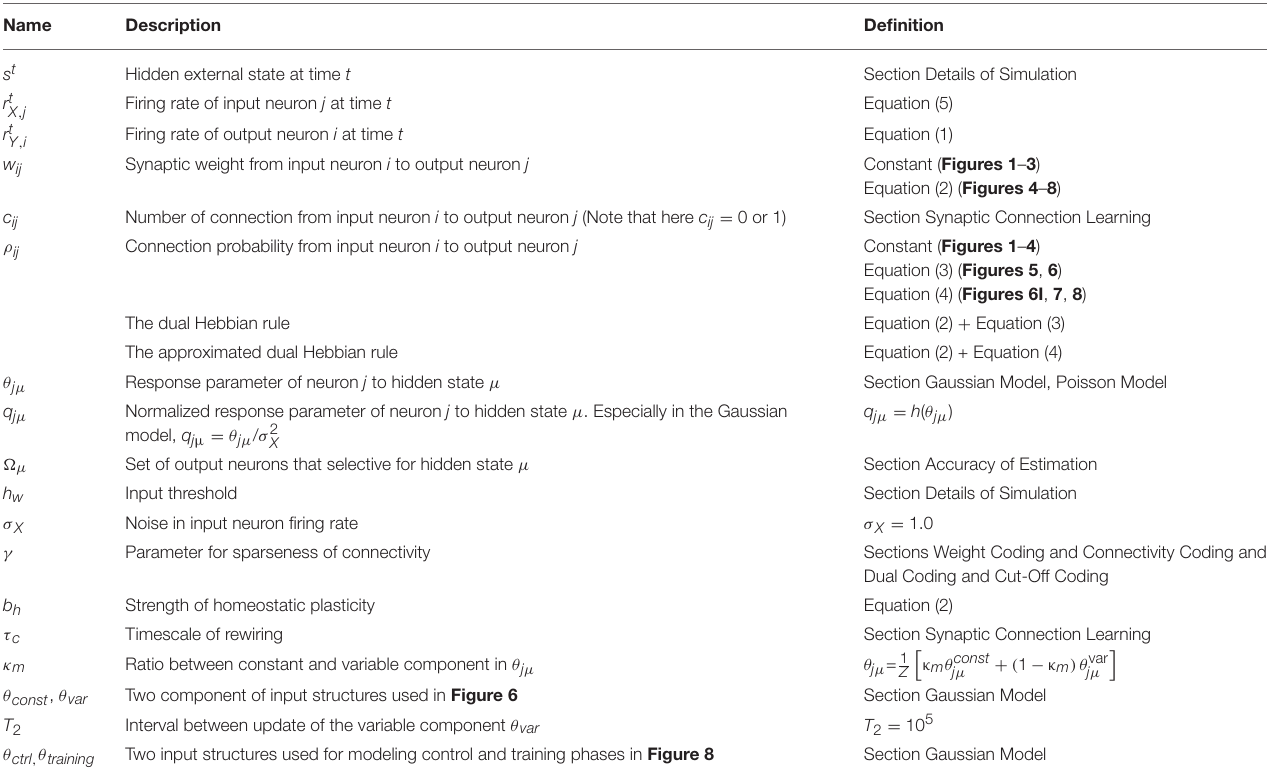
TABLE 1 | Definitions of main variables and